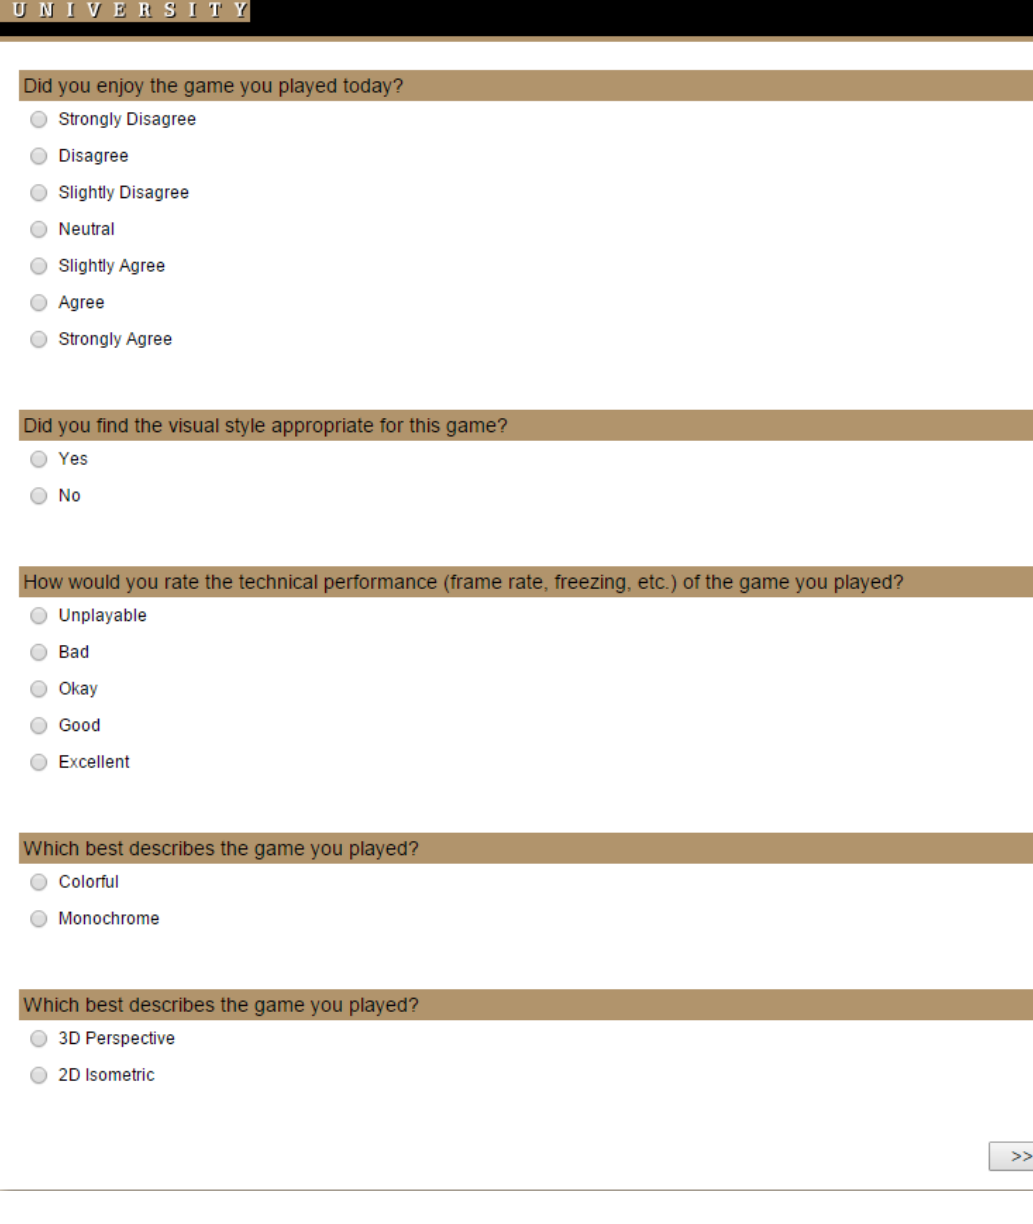
Figure A.2. Enjoyment